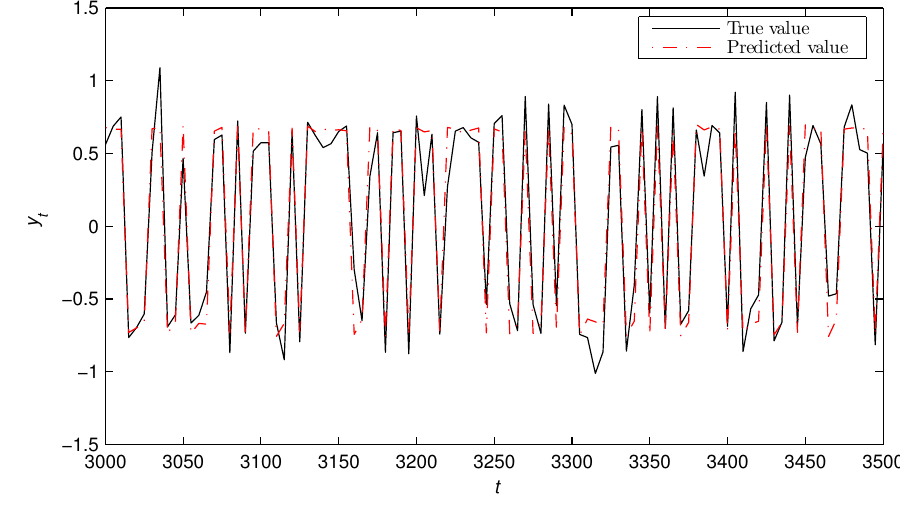
Figure 5. The true outputs and the F-TS-RGLS predicted outputs.